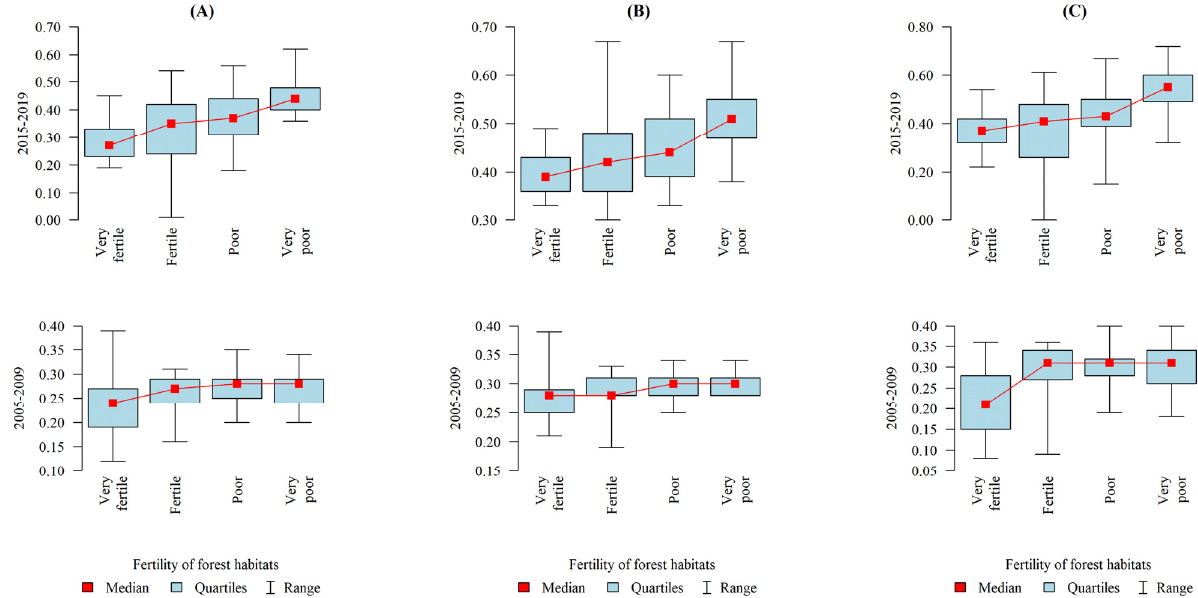
Figure 3. Ranges, medians and quartiles of synthetic financial indicators depending on the fertility of forest habitats.